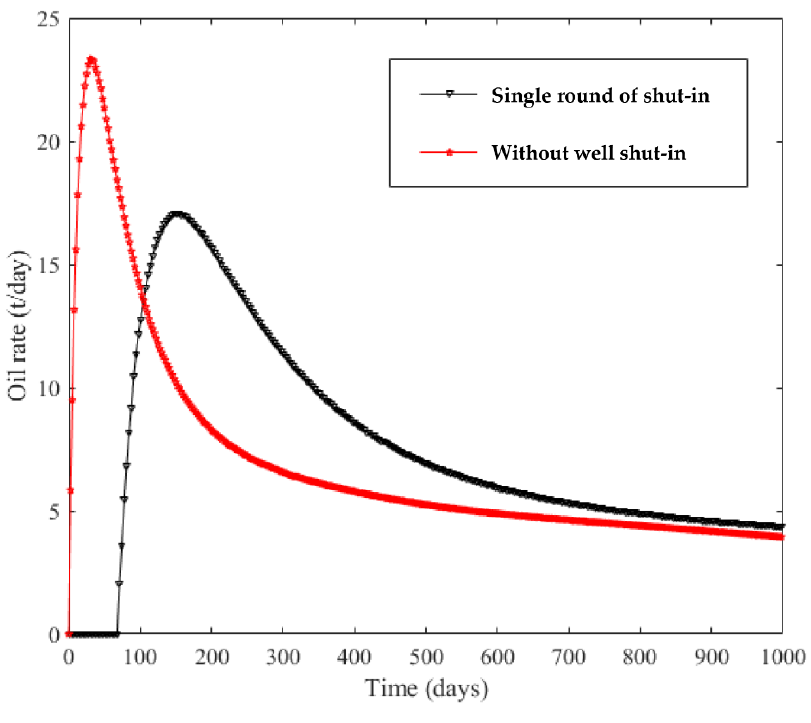
Figure 12. Daily oil rate with a single round of well shut ‐ in operations.